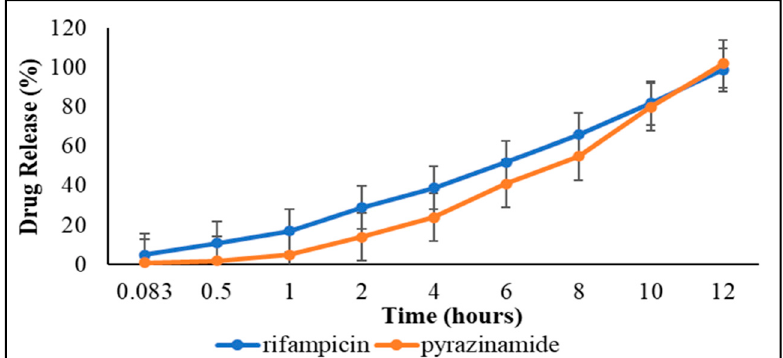
Figure 1. In vitro release of pyrazinamide and rifampicin represented in percentages over twelve hours under biorelevant conditions.